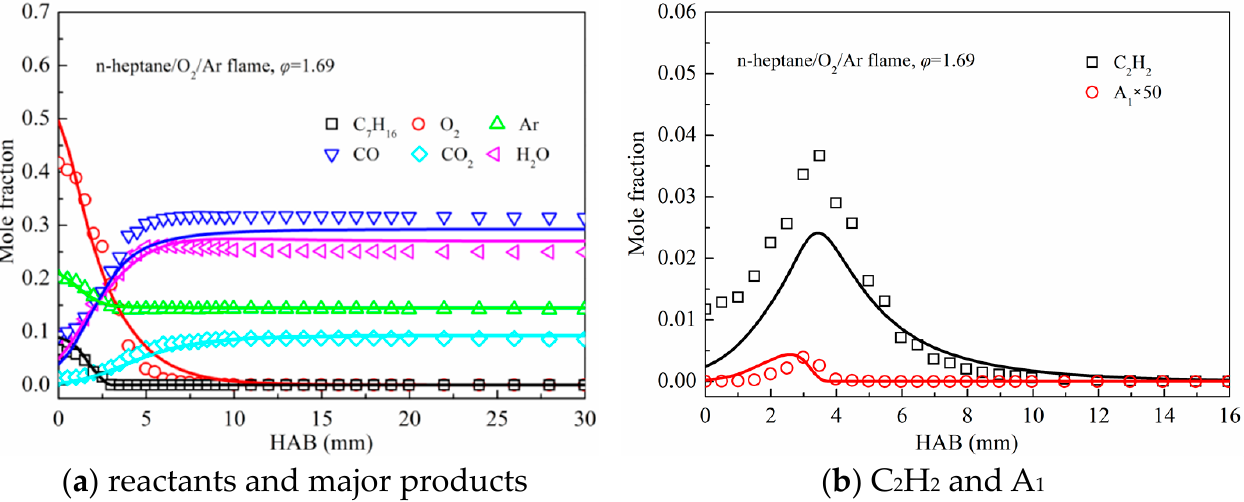
Figure 6. Measured [44] (symbols) and predicted (lines) species profiles in premixed n-heptane flame. An experiment on low-pressure (4.0 kPa) premixed toluene/O 2 /Ar flames for ϕ = 1.0 and 1.75 was carried out by Li et al. [45], and the species concentration profiles in the two toluene flames were determined by using synchrotron vacuum ultraviolet photoionization mass spectrometry. Experimental data from Li et al. [45] were also taken to assess the performance of the proposed mechanism. Figure 7 presents the measured and predicted mole fraction profiles of reactants, major products (CO, CO 2 , H 2 and H 2 O) and two selected intermediate species in premixed toluene flames. The results revealed that the present mechanism’s simulated species concentrations of reactants and major products meet the experimental results quite well. Furthermore, the proposed mechanism can correctly capture the variation trends of two intermediates (C 2 H 2 and A 1 ), but some disagreements between simulations and experiments are observed below 3 mm above the